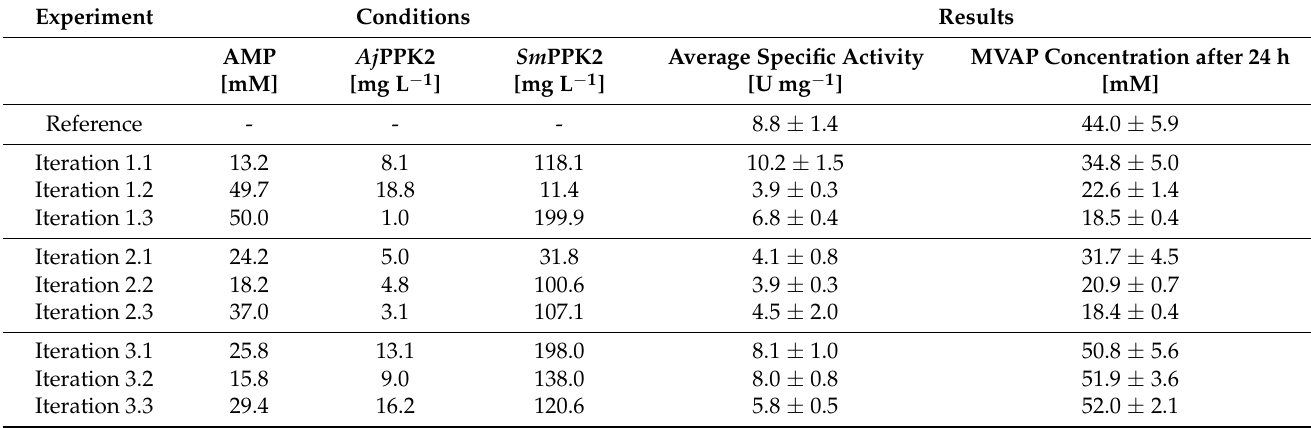
Table 3. Conditions of the experiments as parameter concentrations and the respective results of the iterative optimization approach. Enzyme assays were performed in triplicates with purified enzymes in 1.5 mL Eppendorf tubes. The enzyme assays contained 0.2 mg mL − 1 of MVK, 50 mM of MVA, 55 mM of polyP, 3 mM of Na 3 VO 4 , 0.043 mM of NADP + , 0.43 mM of CoA, 170 mM of glucose, 200 mM of NaOAc, and 20 mM of MgCl 2 in 0.35 mL of the reaction volume, filled up with activity buffer (100 mM Tris-HCl, 150 mM NaCl, 10% glycerol, 20 mM MgCl 2 , pH 7.5). AMP, Aj PPK2,